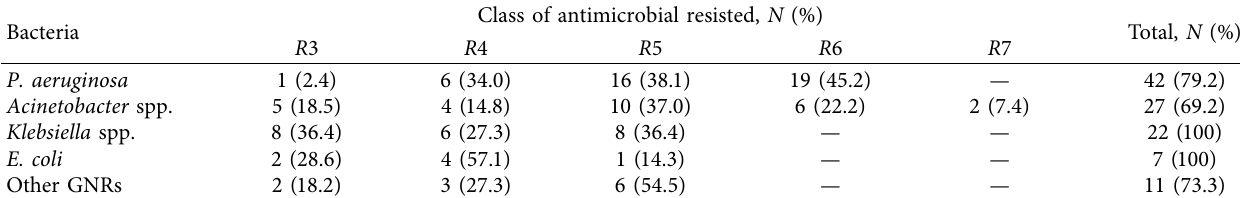
Table 3: Multidrug resistance of Gram-negative bacteria isolated from children with BWI. Class of antimicrobial resisted, N Bacteria